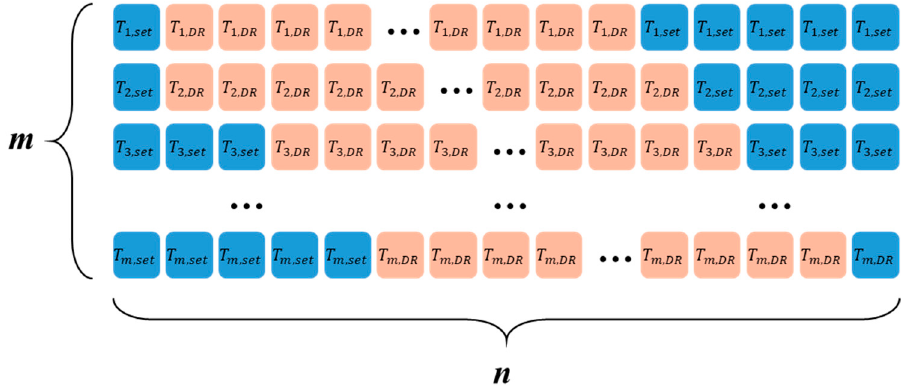
Figure 5. Schematic diagram of the equally spaced queuing method.